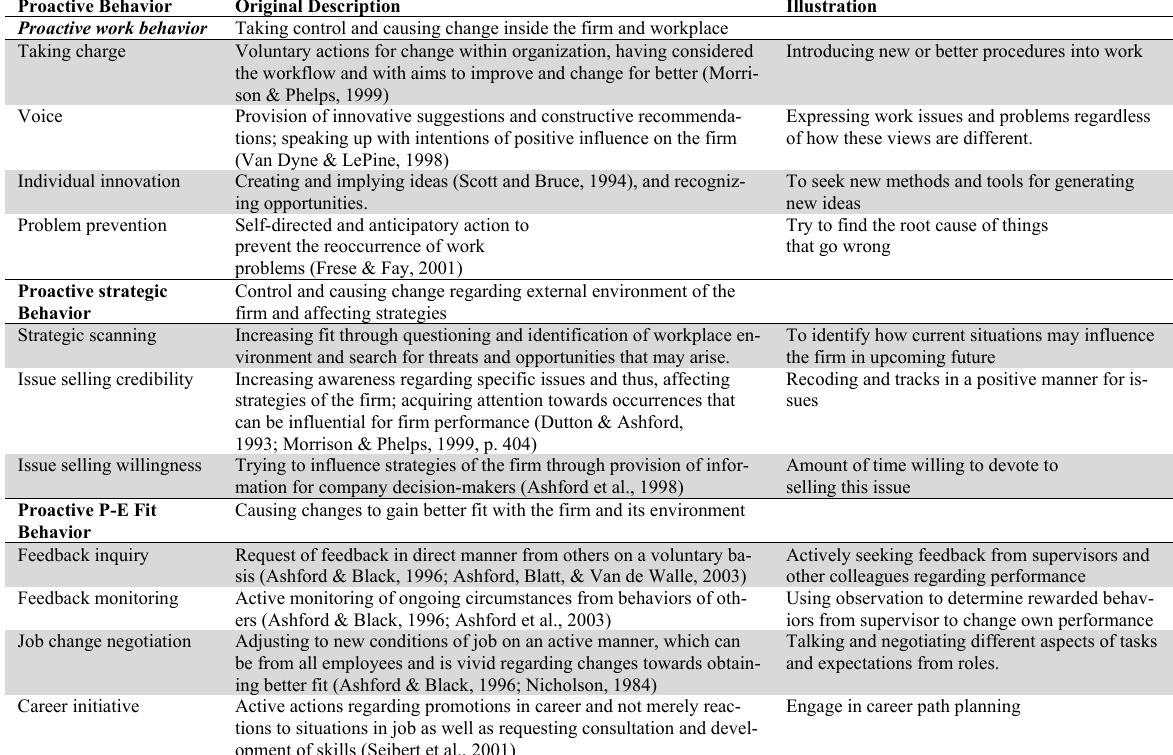
Proactive Behavior Categories, Definitions and